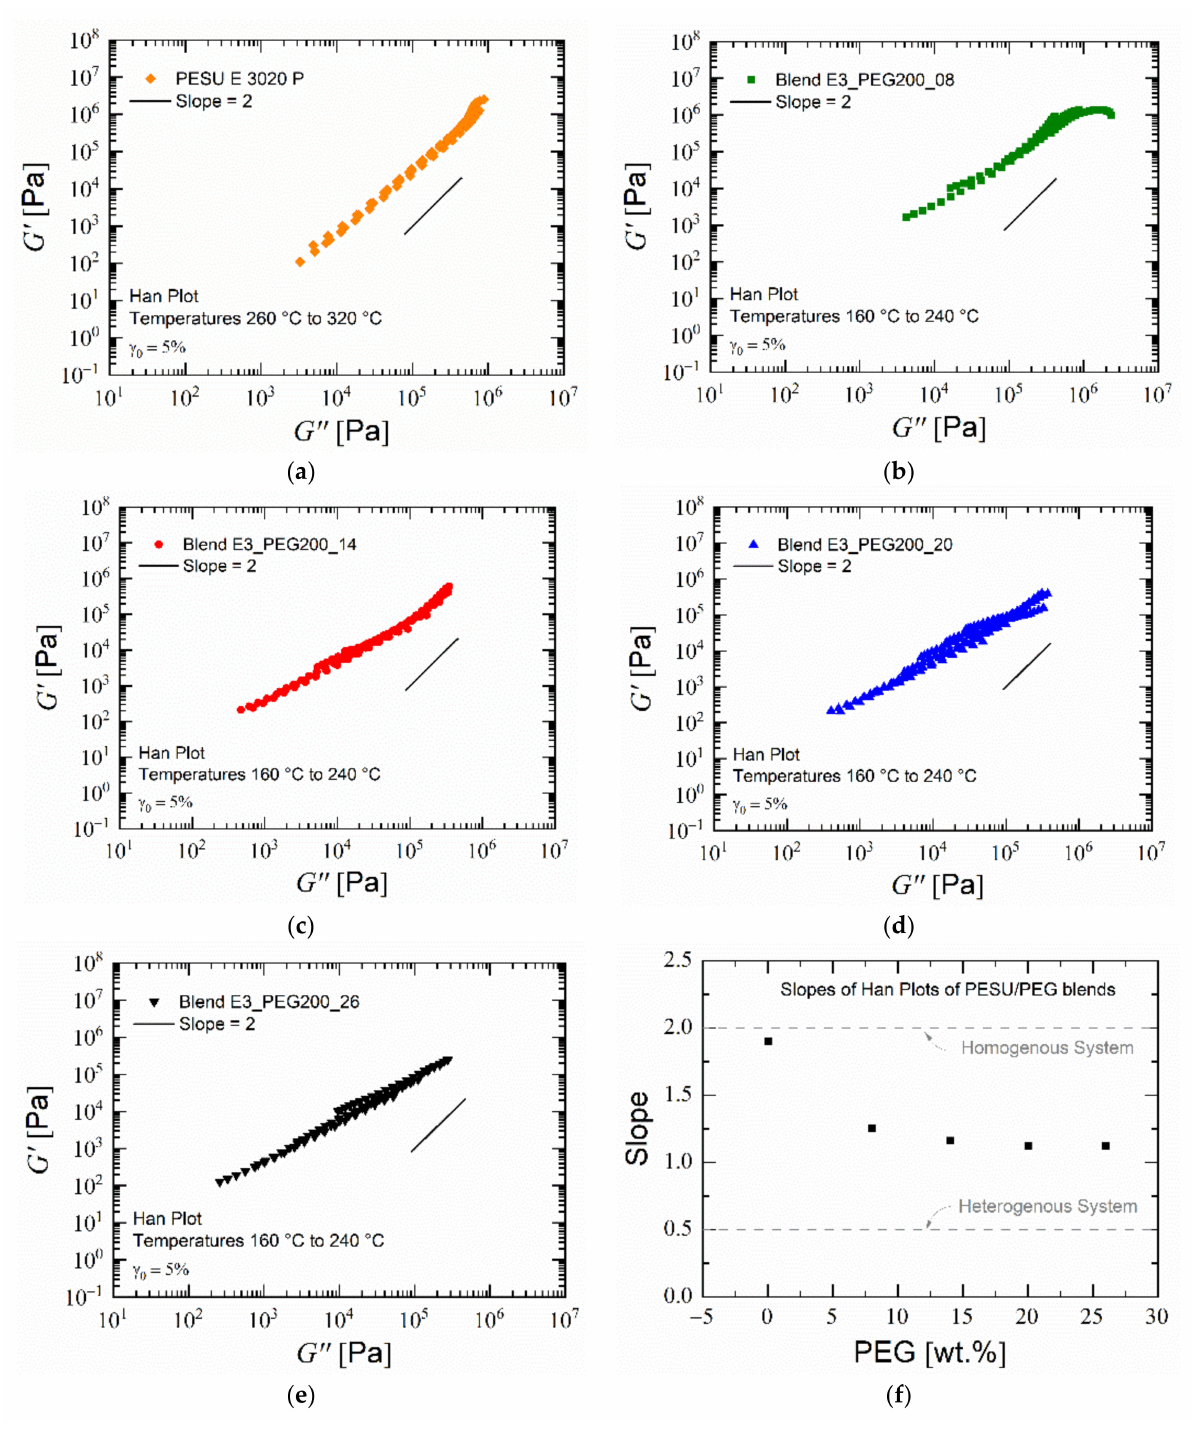
Figure 7. ( a – e ) Han plots of PESU and blends PESU/PEG200; ( f ) slopes of Han plots. Rheological analysis carried out on the PESU/PEG blends showed a decrease in complex viscosity with an increase in PEG content at a given temperature, as seen in Figure 8a. The difference between the viscosities of the blend with 8% PEG and the blend with 14 % PEG was the largest, whereas the difference between the blend with 20% and 26% was the smallest. These differences were similar to those seen in glass transition temperatures in DSC measurements. This provided an indication that, above a certain percentage between 20% and 26%, PESU was fully saturated with PEG and excess